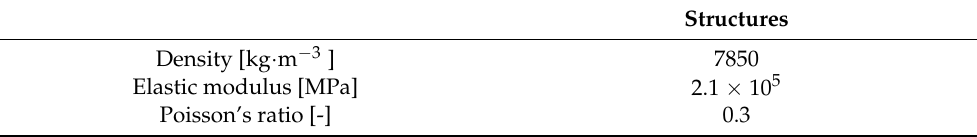
Table 3. Material properties of the